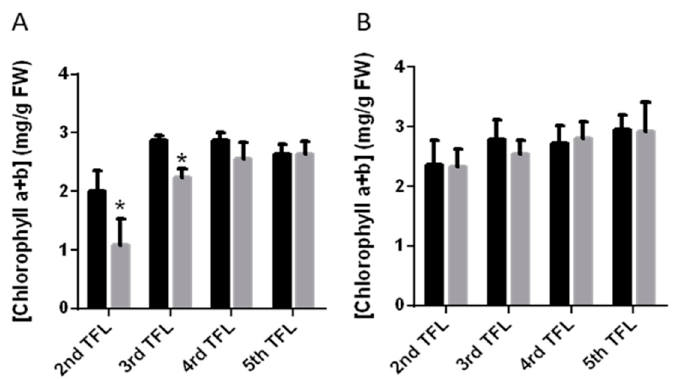
Figure 2. Concentration of chlorophylls in the 2nd, 3rd, 4th and 5th trifoliate leaves of P. vulgaris PMB-0220 ( A ) and PHA-0683 ( B ) plants under control conditions and after 10 days of drought. Data were means of three independent repetitions, and 3 plants were used per sample in each replicate. Asterisks indicate statistically significant differences (* p < 0.05).